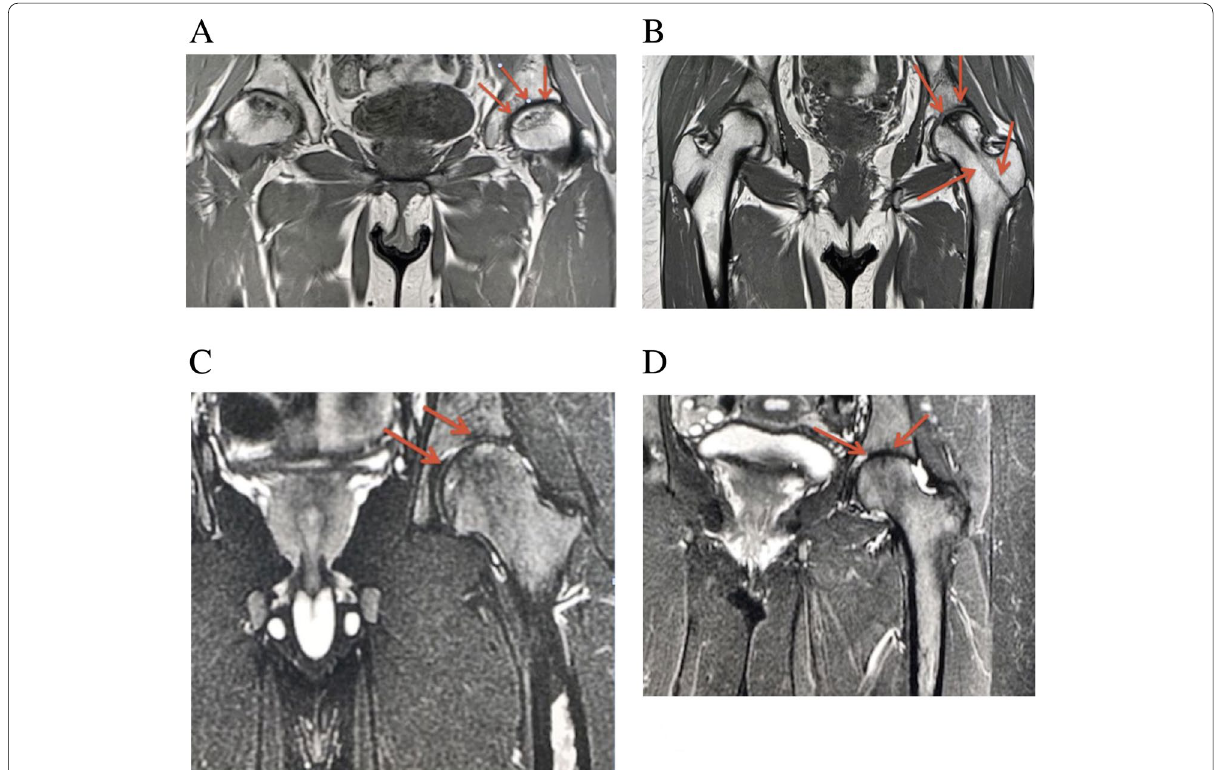
Fig. 3 A Coronal T1 fat suppressed image of the pelvis demonstrates a geographic area of abnormal signal intensity in the left femoral head (red arrows) compatible with ANFH. B Coronal T1 weighted image performed 4 Months after demonstrates interval improvement of ANFH as well ghost tracts from prior drilling through which osteoblasts were transplanted (red arrows). C Coronal Short‑TI Inversion Recovery weighted image performed 18 Months after demonstrates further interval improvement in surface area involvement of the left femoral head involvement by ANFH (red arrows). D Coronal Short‑TI Inversion Recovery weighted image performed 36 Months after demonstrates complete resolution of the femoral head ANFH (red